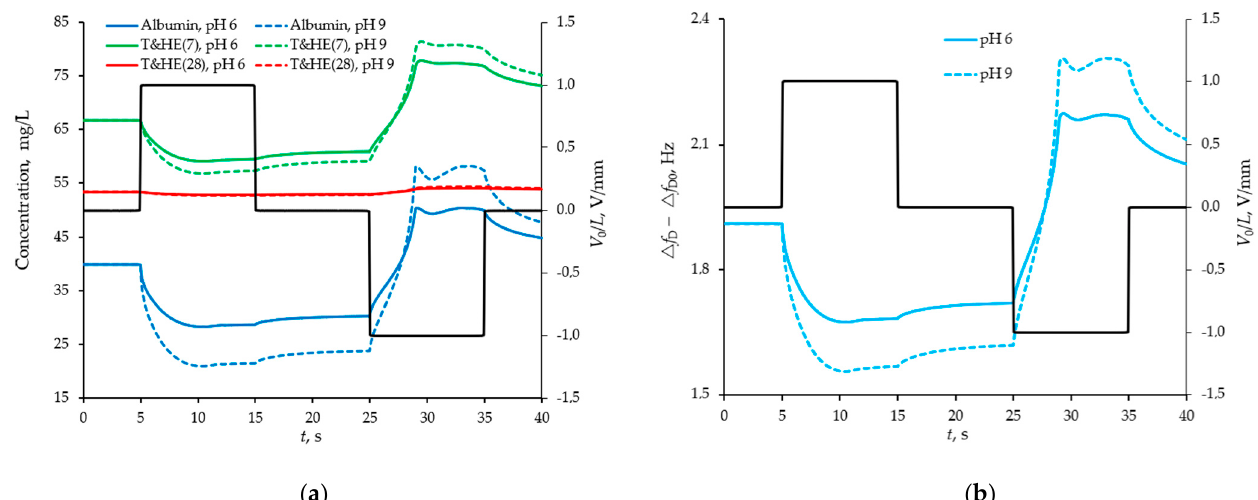
Figure 6. Average concentration of proteins trapped in the space between the barriers of the sensor with the structured surface at two different pH values ( a ) and the difference response from two sensors (with smooth and structured surfaces) in the form of a shift of their resonance frequencies ( b ) by manipulation of the model buffer solution with proteins by external pulsed field. Concentrations and frequency shifts (left axes) are shown with coloured curves, and pulse actions (right axes) are shown with a black broken line.